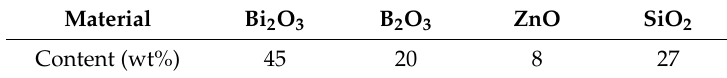
Table 7. Composition of the glass